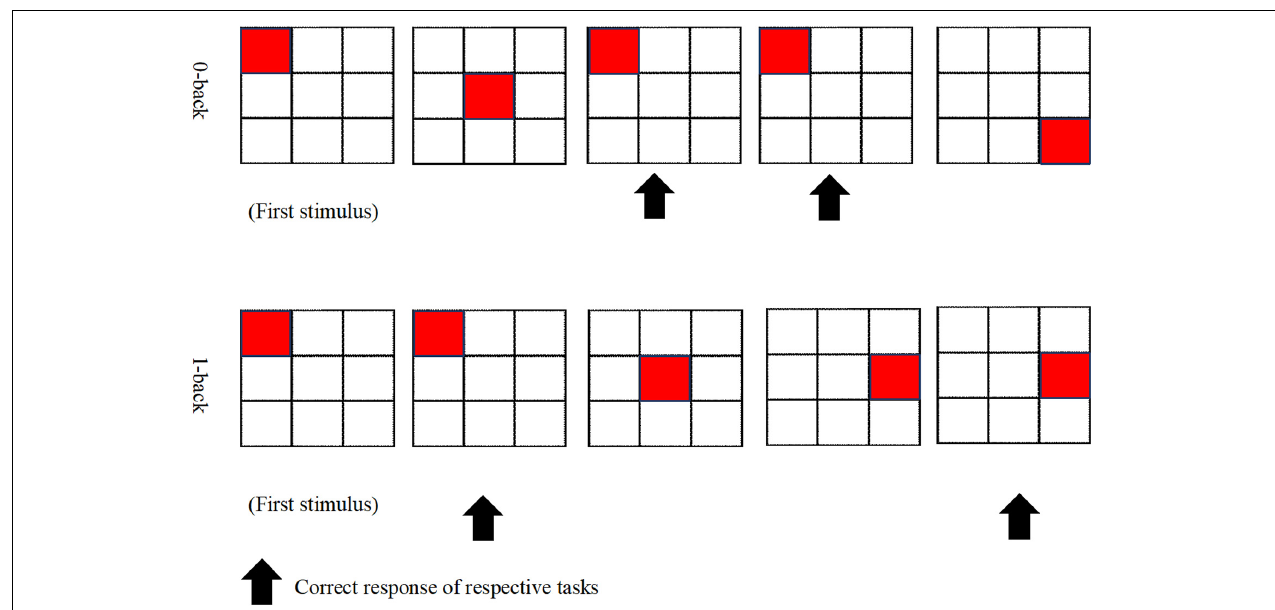
FIGURE 1 | 0-back and 1-back